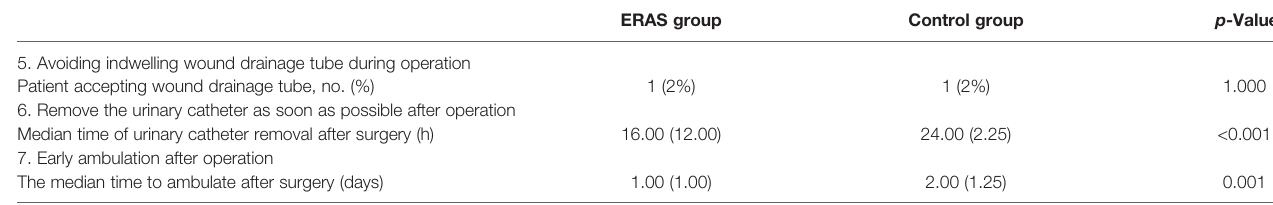
TABLE 5 | The third part of ERAS measures and effects.